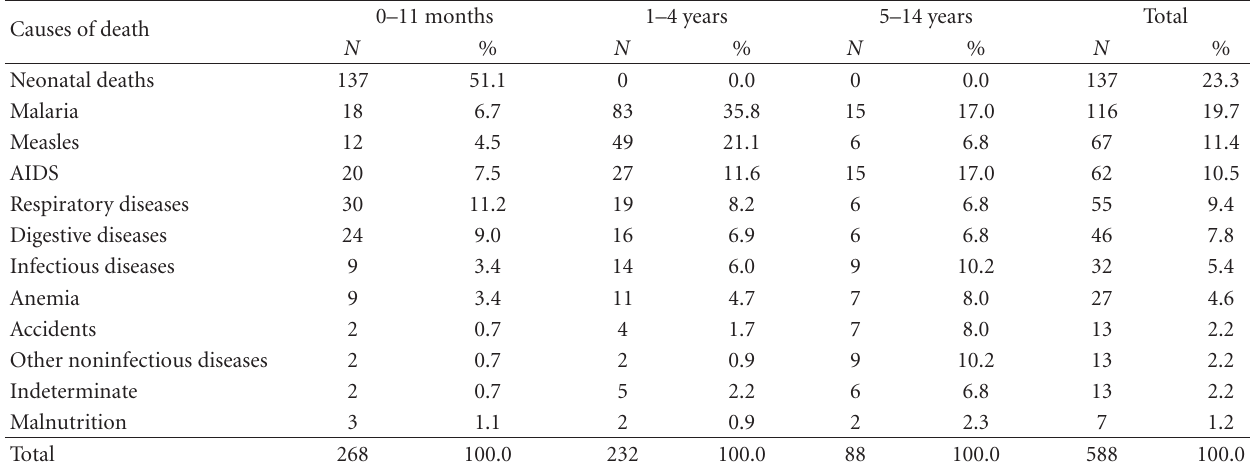
Table 3: Causes of deaths according to the age of the children ( n = 588).